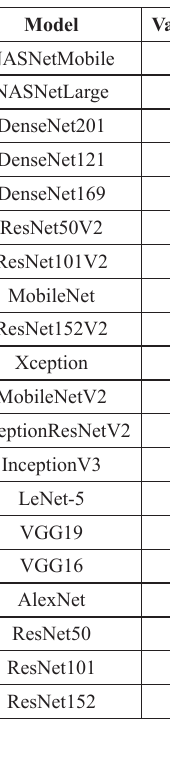
Table 3. Model’s accuracy on train and validation